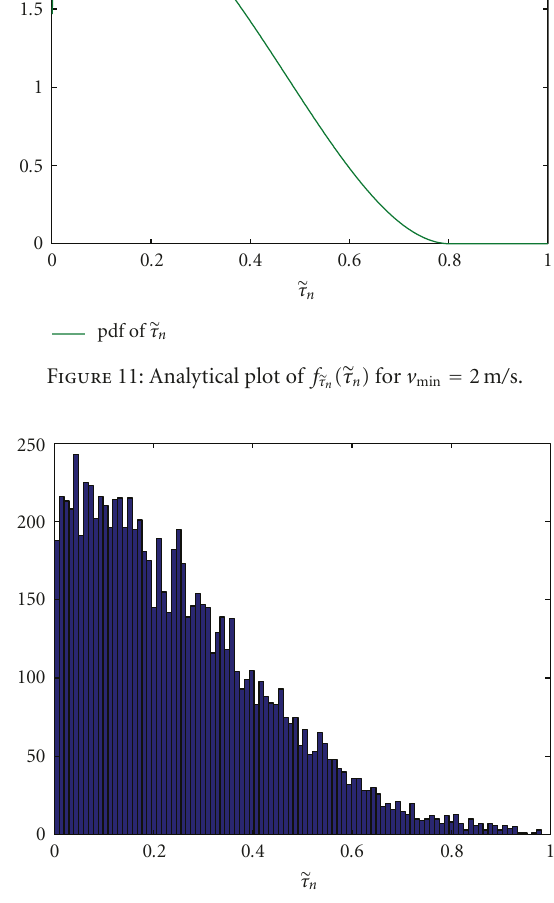
Figure 12: Histogram plot of (cid:9) τ n for v min = 2m /